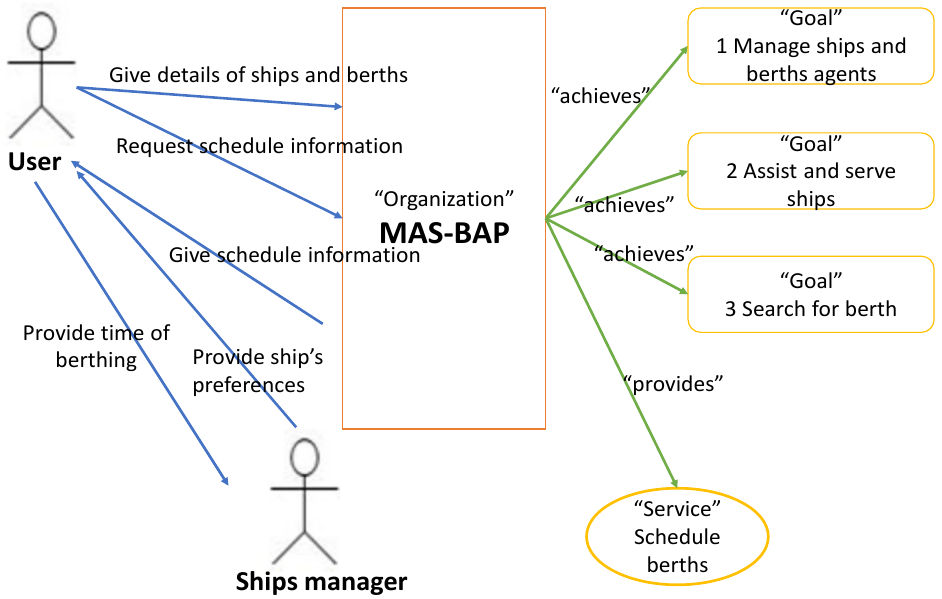
Figure 6. Organizational model of O-MaSE.